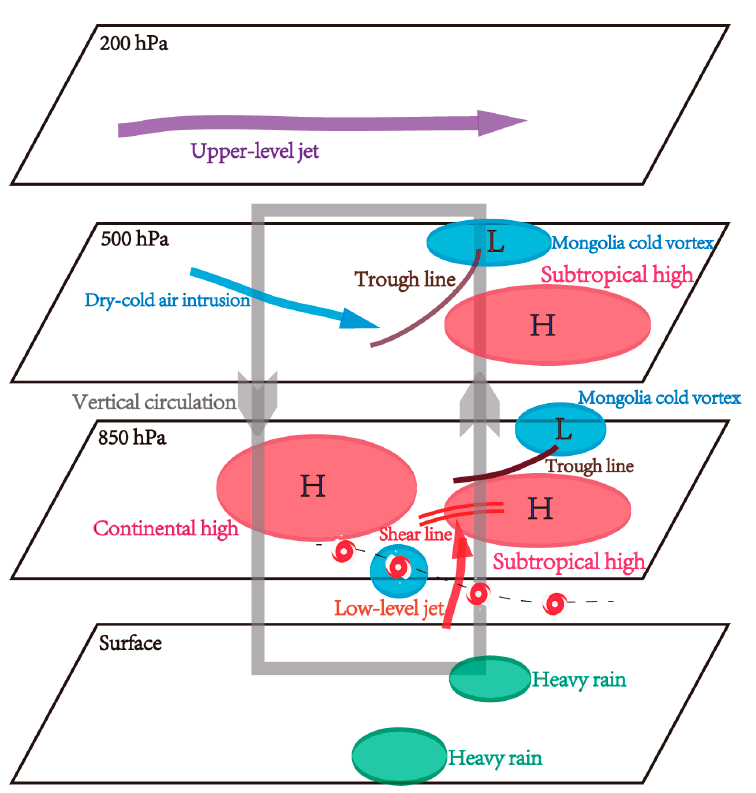
Figure 11. Schematic diagram of the physical mechanisms for the remote rainstorm caused by Typhoon Mangkhut.